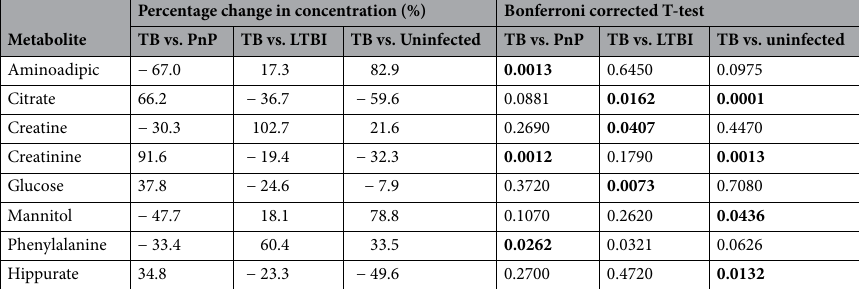
Table 3. Relative change in the concentration of the identified metabolites. TB, tuberculosis; PnP, pneumococcal pneumonia; LTBI, latent TB infection; uninfected, individuals without infection; PC: Principal